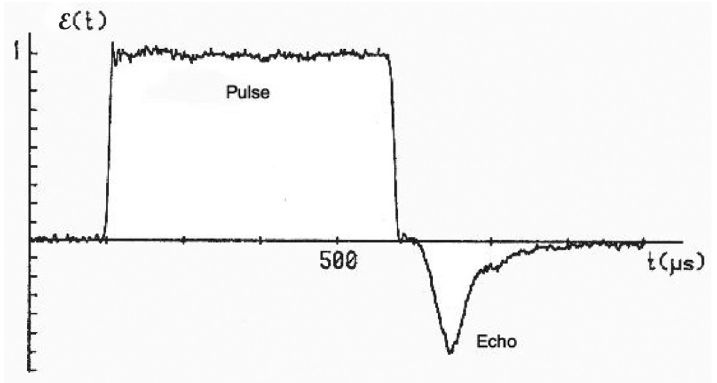
Fig. 28. Signal of pulse and echo measured at the strain gage station.